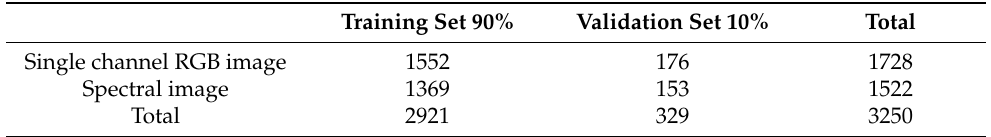
Table 4. DeeperLabC training data